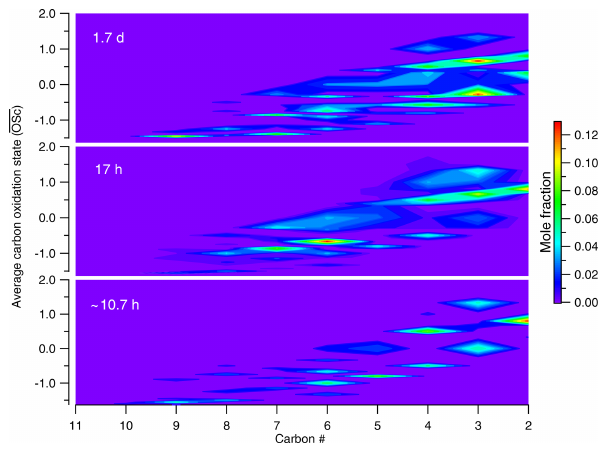
Figure 3. Evolution in OSc–nc space for canola oil SOA un- der different conditions of photochemical aging. As the oxidation progresses in the atmosphere, more compounds are formed with smaller nc and higher OSc, suggesting fragmentation to be a domi- nant pathway of oxidation for cooking emissions in the